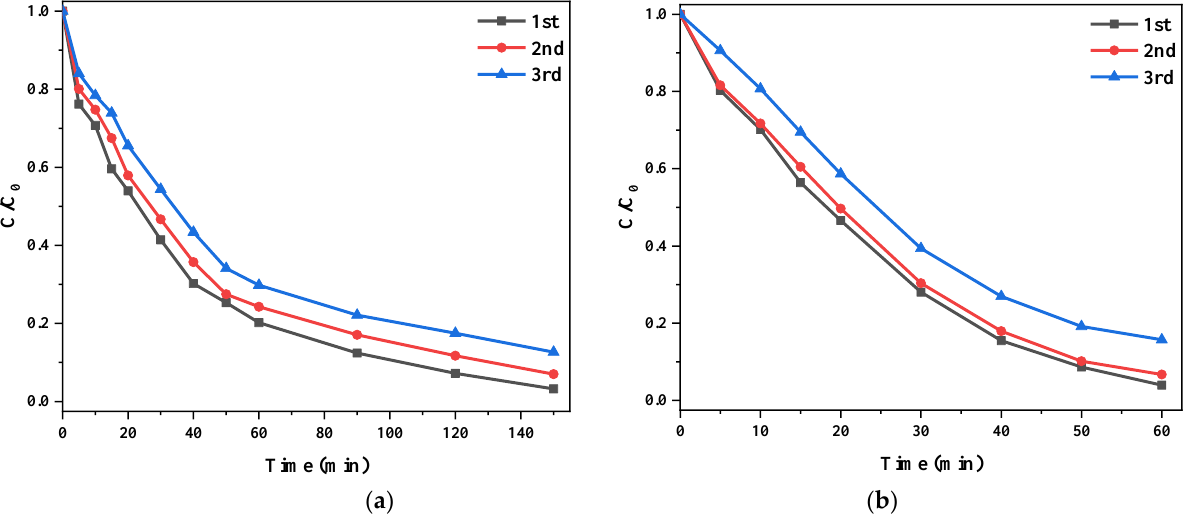
Figure 8. Phenol degradation efficiency of recycled ( a ) octahedral Mn 3 O 4 ( b ) Mn 3 O 4 NPs catalyst. Reaction condition: phenol concentration = 25 ppm, catalyst = 0.4 g/L, PMS = 2 g/L.